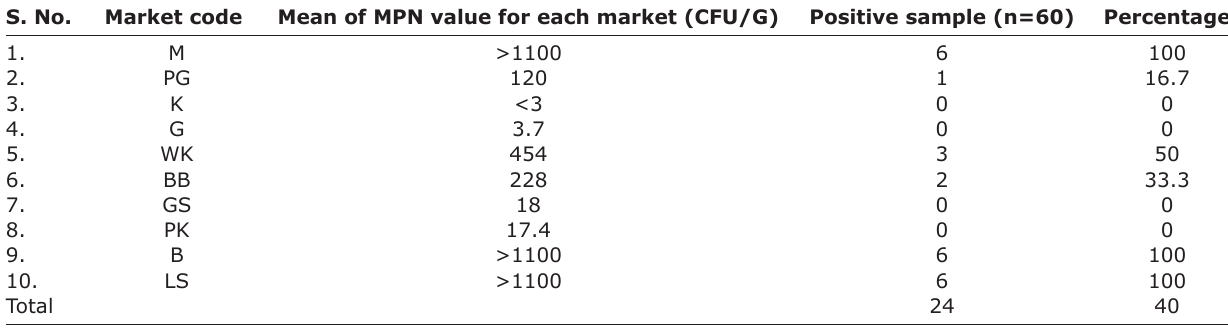
Table-2: Results of Escherichia coli in chicken meat. S.